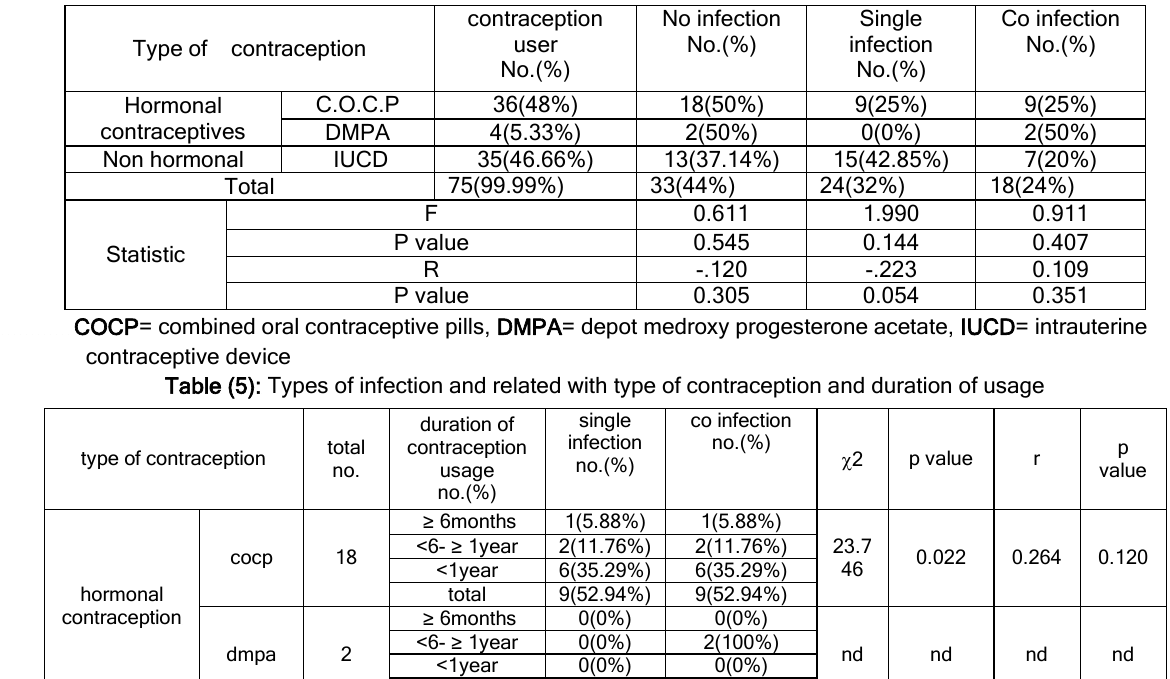
*ND: not detected Table (4): comparison between different types of Contraceptives regarding infection type